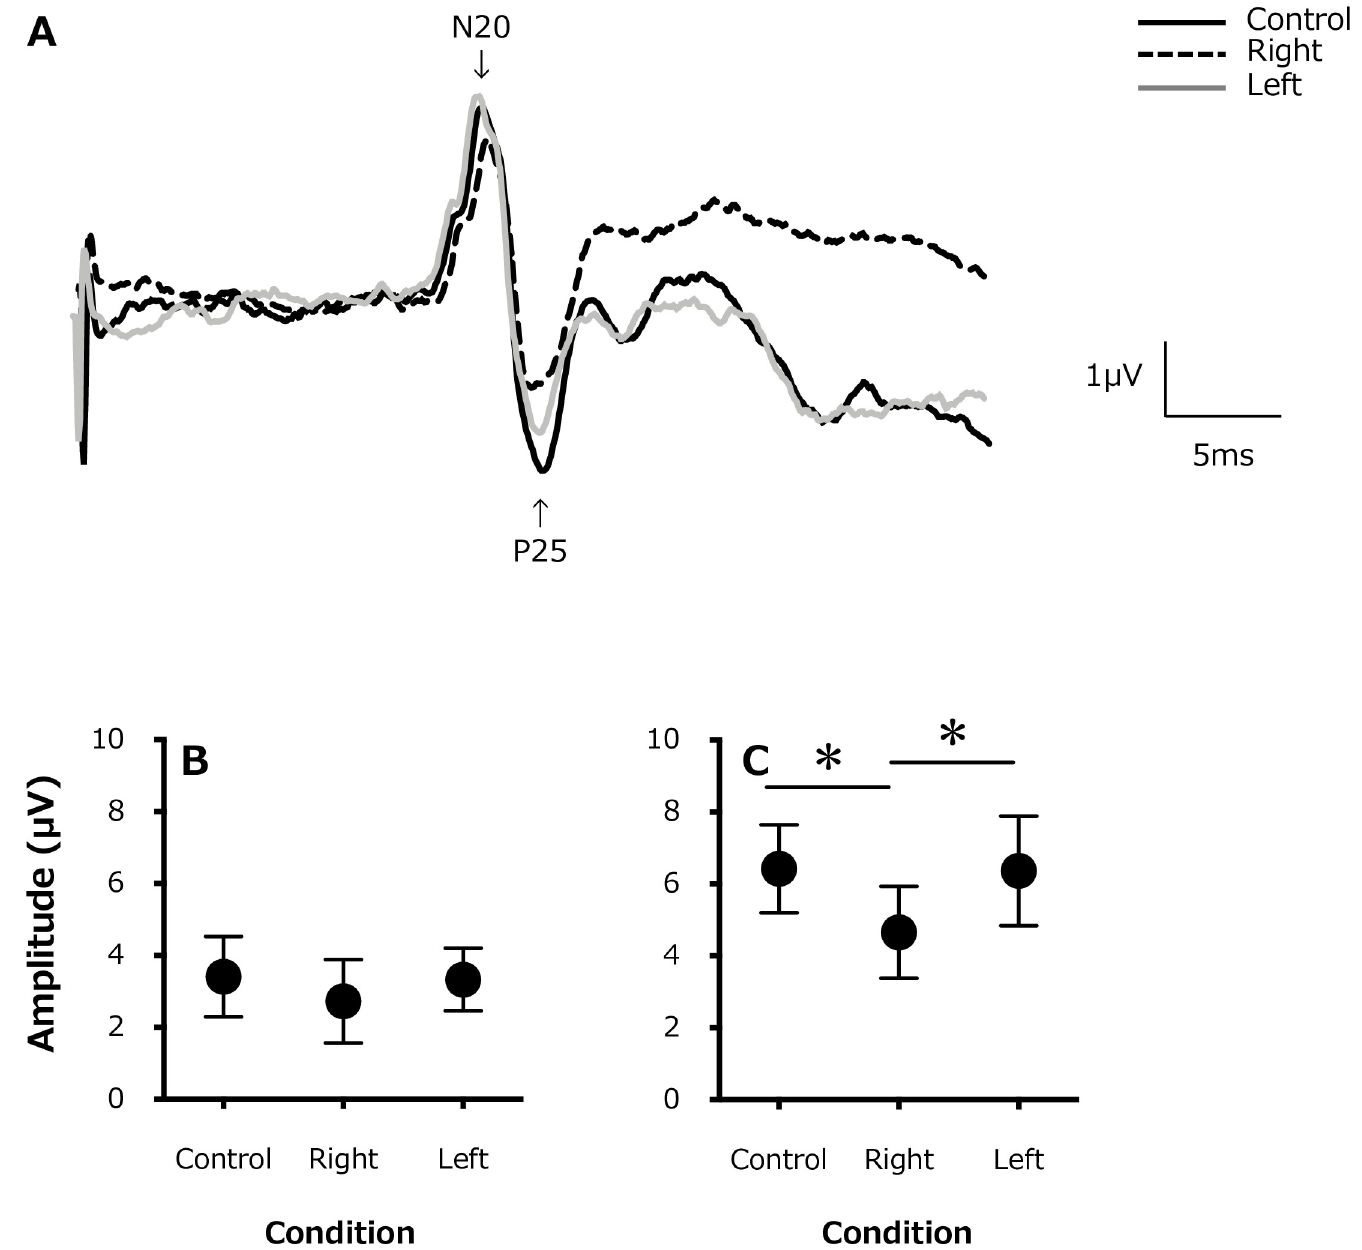
Fig 2. (A). A typical example of somatosensory evoked potentials (SEPs) waveforms from a single participant (for 200 stimulations) for the control (rest) condition (solid black line), in the active contraction (right) side (black dashed line), and contralateral (left) side (gray solid line). Changes in the average SEP amplitude (B) at N20 and (C) P25. � , P <